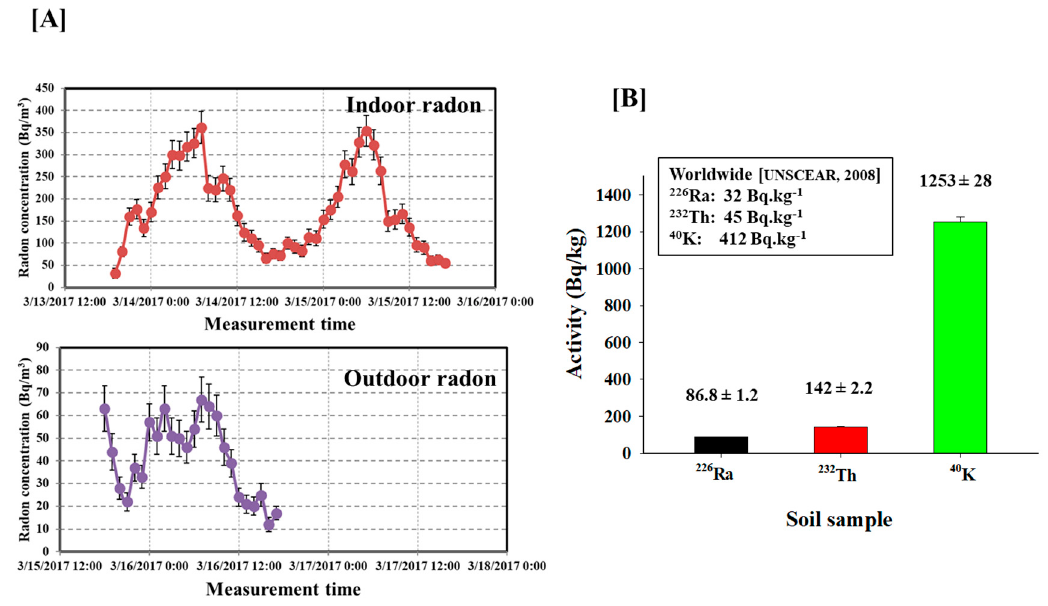
Figure 3. Measurement of radioactivity concentration in air and soil between 13–16 March 2017 in the dwelling with the highest concentration of radon during the fire winter burning season. ( A ) Temporal variation of radon activity concentrations measured using the AlphaGUARD. ( B ) Activity concentration of 226 Ra, 232 Th and 40 K in the studied soil samples.